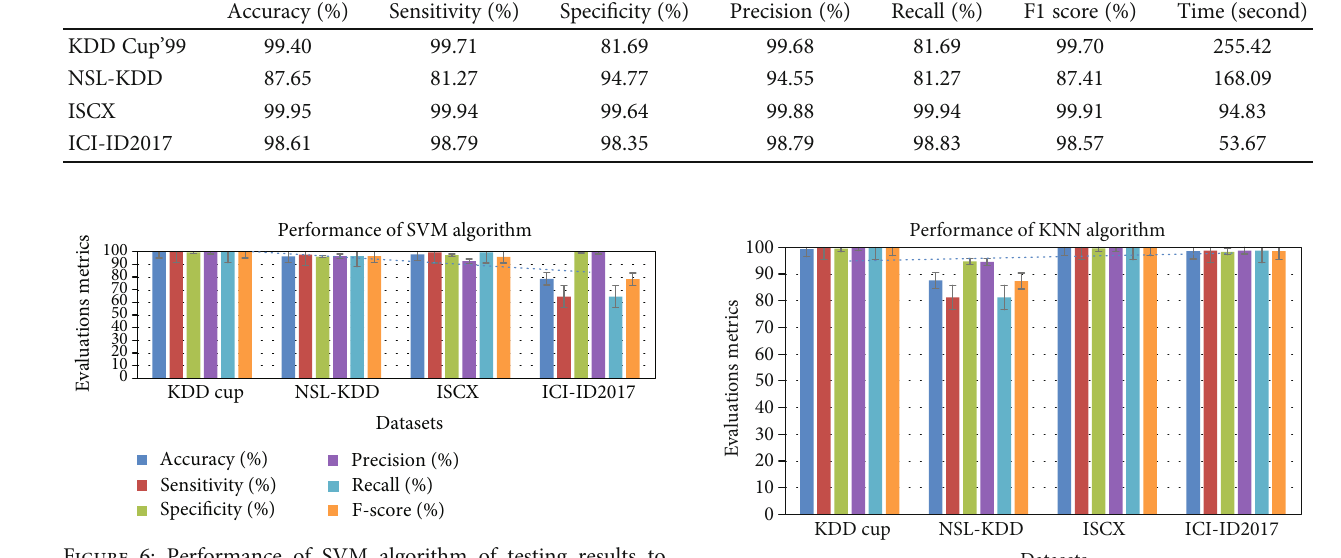
Figure 6: Performance of SVM algorithm of testing results to classify cyberattacks.